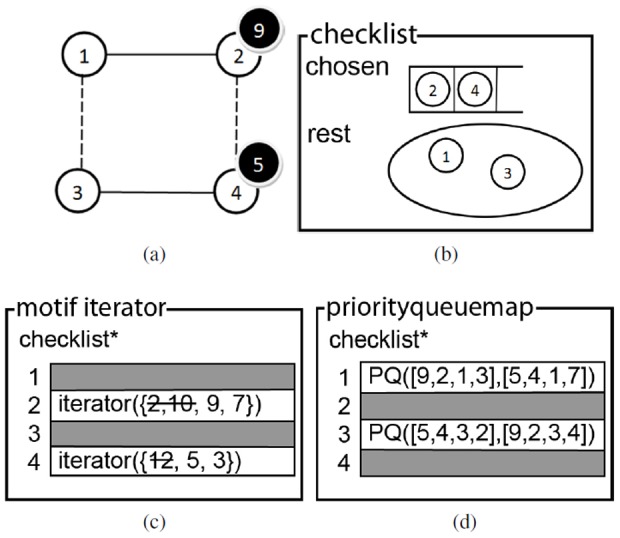
Example of data structures.We are looking for a 4-node motif. In the motif instance (a) network node 9 is mapped on motif node 2 and network node 5 is mapped on motif node 4. These motif nodes were added (in the correct order) to the chosen list of the checklist (b), while the other two motif nodes (1 and 3) remain in the rest set. The motif iterator (c) contains two iterators that are of importance, namely the ones for the motif nodes of the chosen list. These iterate over the possible network nodes that can be mapped on the motif nodes. The priorityqueuemap (d) only contains valuable priority queues for the motif nodes 1 and 3. Each priority queue contains a priorityobject for each network node that is already mapped in the instance.